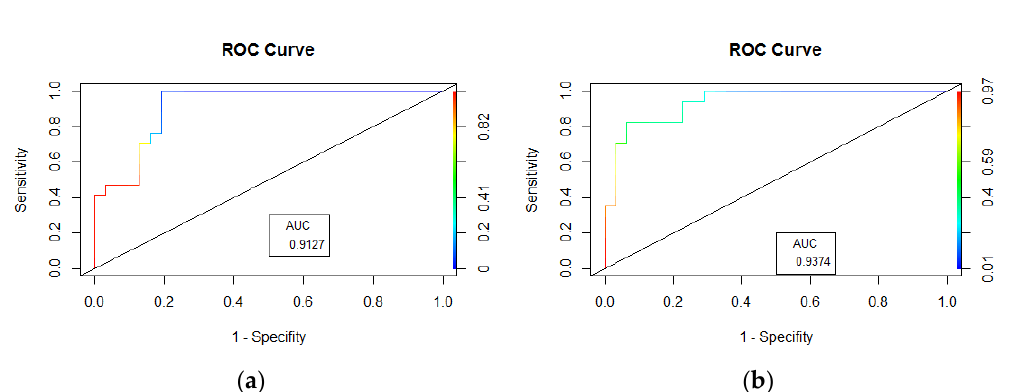
Figure 3. Area under ROC curve: ( a ). Artificial Neural Network (ANN) and ( b ) Random Forest (RF) of P. arinasae . Table 1. AUC, kappa, and error model of ANNs. Table 2. AUC, kappa and error model of